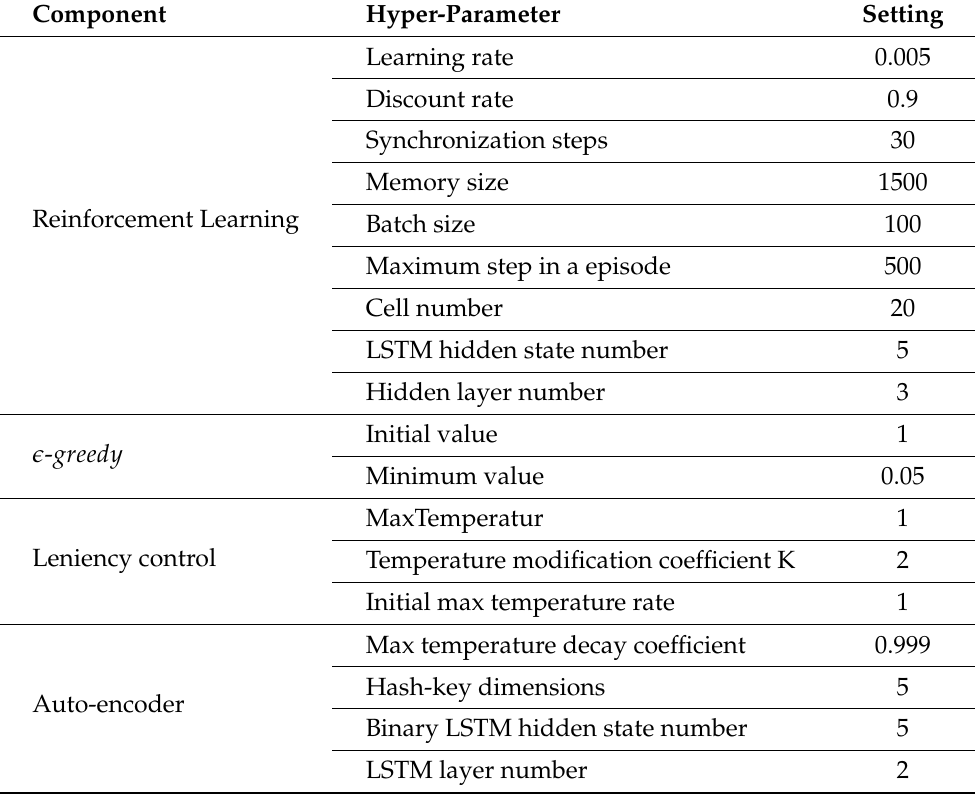
Table 5. Hyper-parameters of LC-MARL.